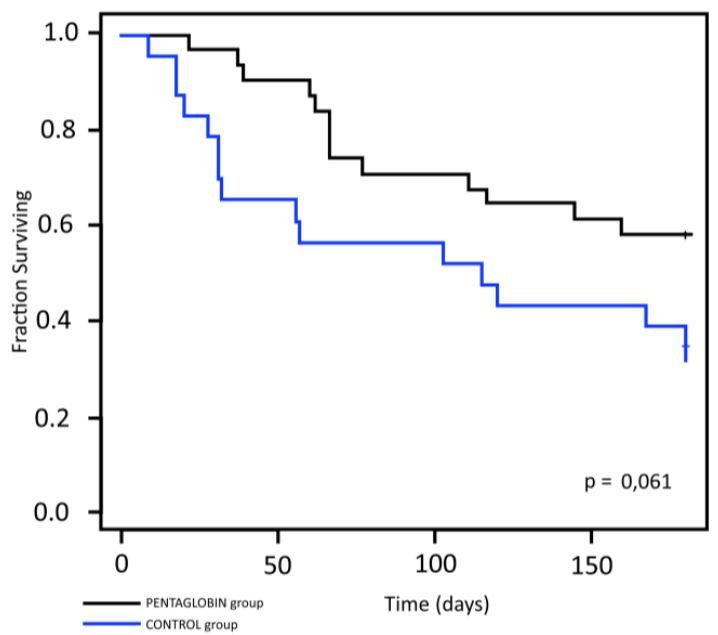
Figure 5. Kaplan–Meier survival curves in two groups calculated for deaths, excluding mucositis and enteritis.